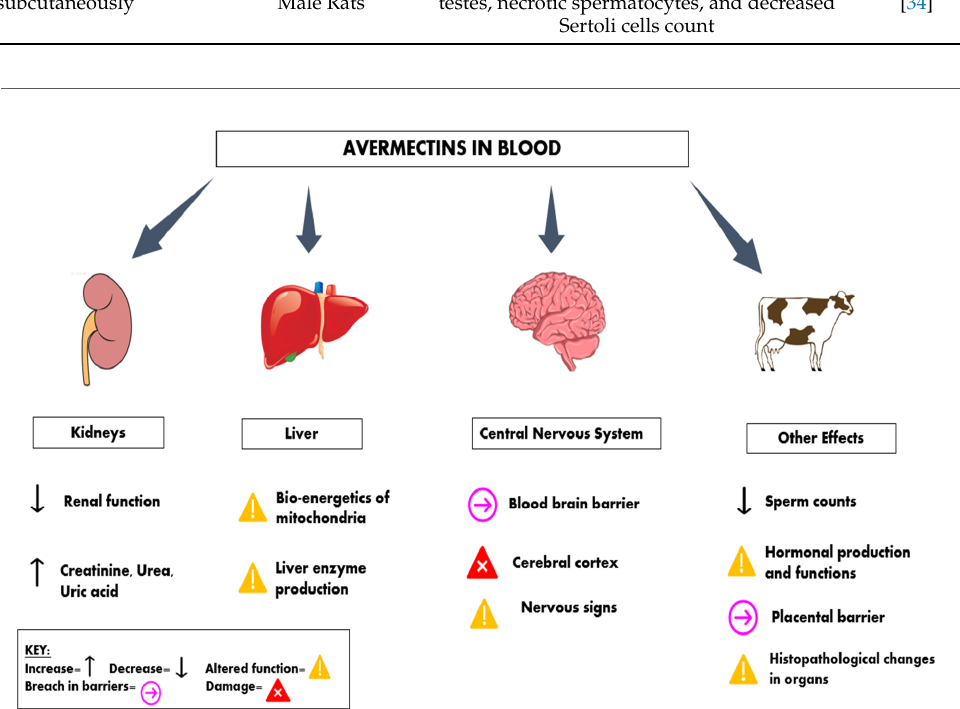
Figure 4. Description of avermectins-induced